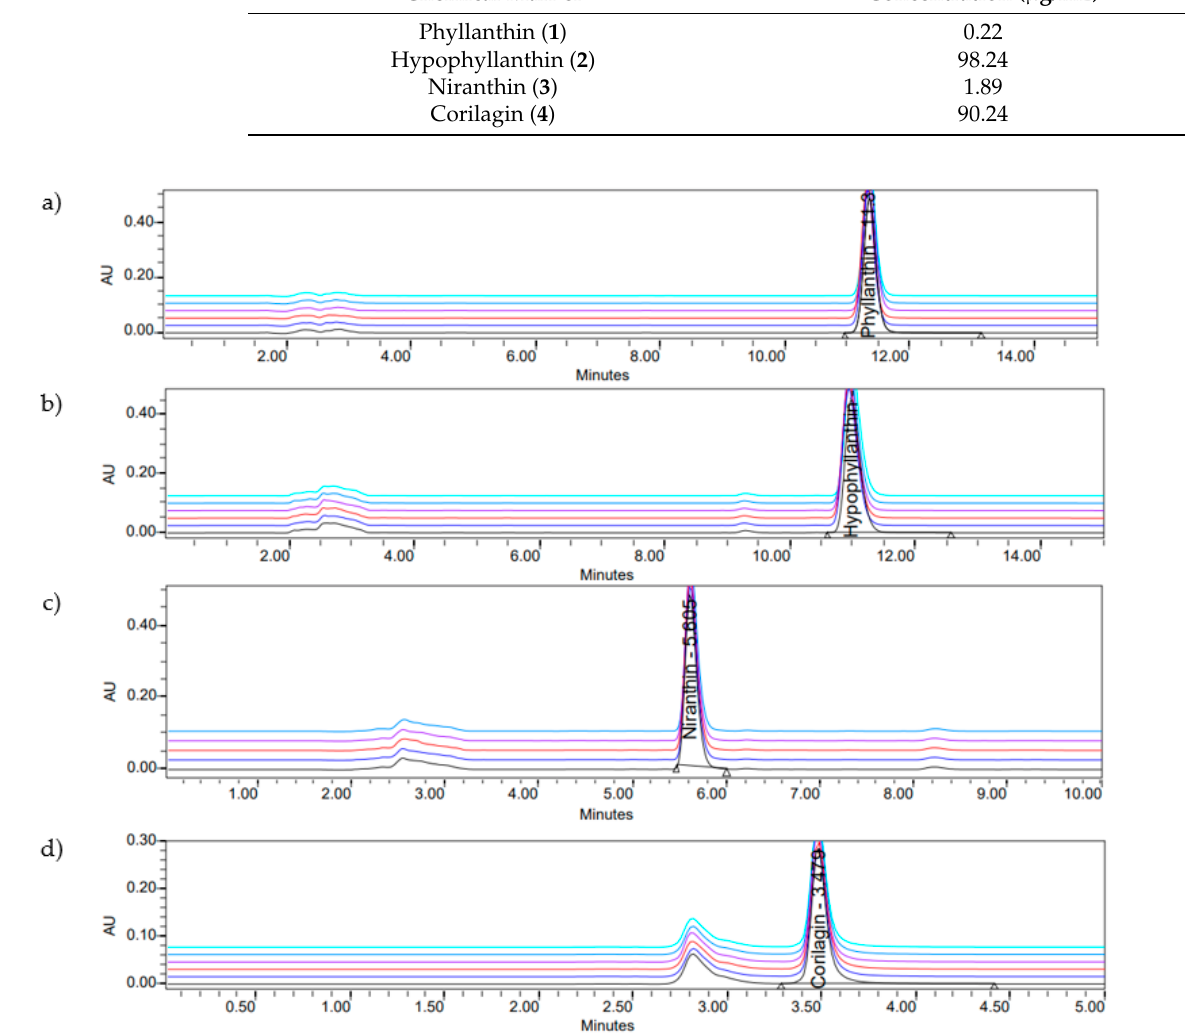
Figure 2. HPLC profile of P. amarus compounds: ( a ) phyllanthin; ( b ) hypophyllanthin; ( c ) niranthin; ( d ) corilagin.